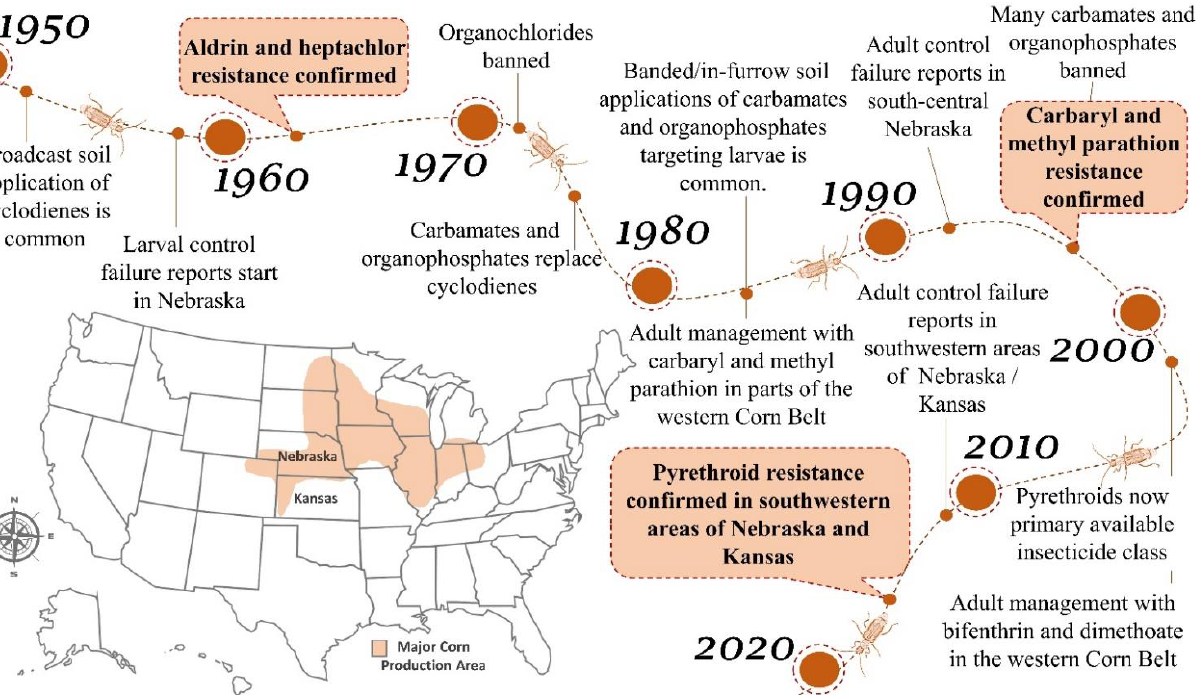
Figure 2. The agricultural region in the midwestern U.S. that is a major producer of maize is called the Corn Belt. This figure shows the major maize grain production area within this region, a Dvv insecticide use/field-evolved resistance timeline associated with continuous maize, and the geographic location of states Nebraska and Kansas where Dvv resistance to multiple insecticides has occurred. Maize grain production area is based on USDA-NASS 2015–2019 data [42,43].